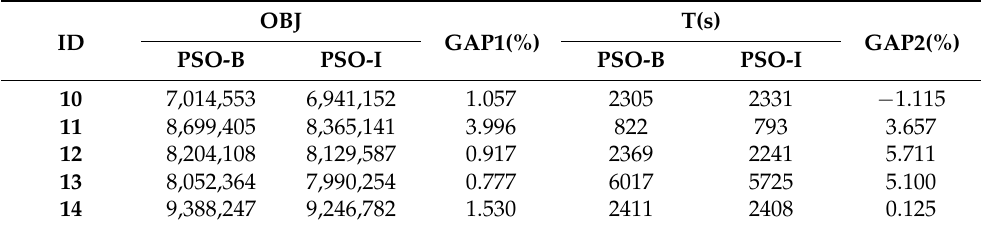
Table 2. The experimental results of PSO-B and PSO-I. “GAP1” represents the value of formula (PSO-B—PSO-I)/PSO-I × 100% with “OBJ” and “GAP2” represents the value of formula (PSO-B— PSO-I)/PSO-I × 100% with “T”.